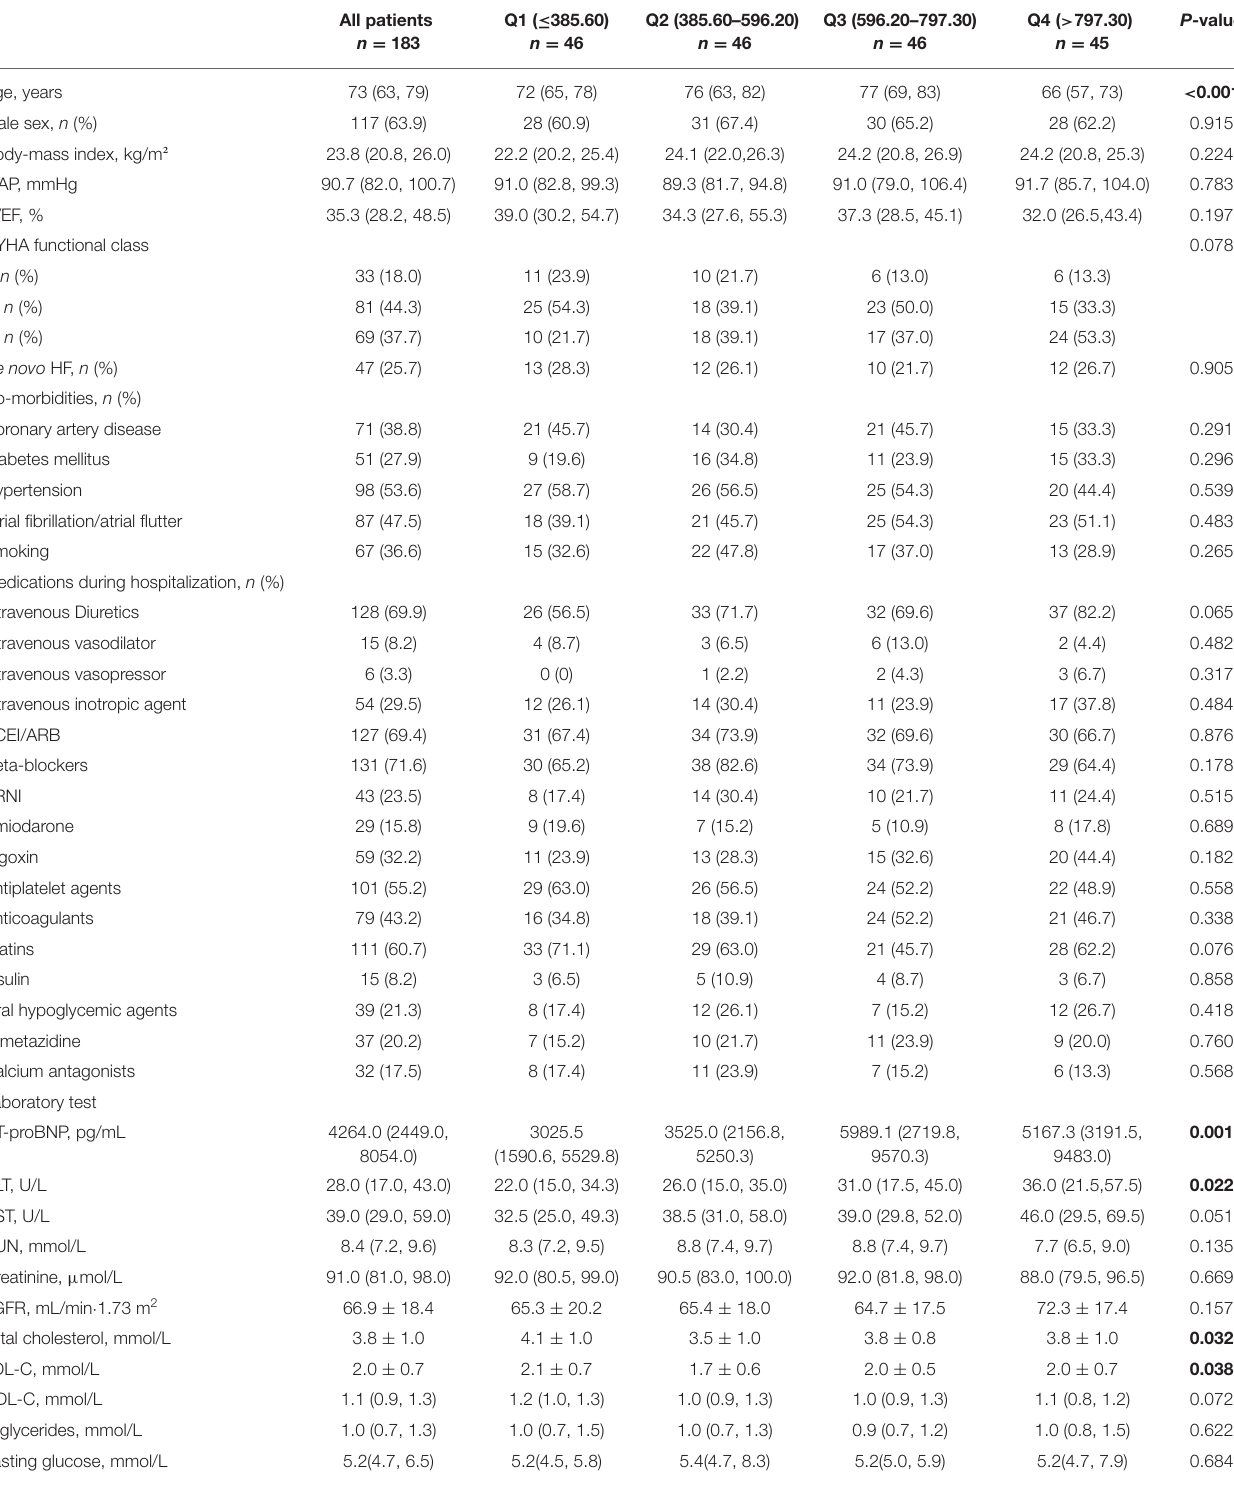
TABLE 1 | Characteristics of patients with acute heart failure at baseline by quartiles of serum free fatty